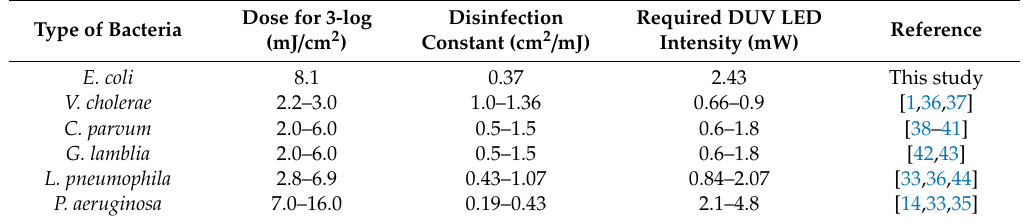
Table 1. Dose requirements vs. type of bacteria (first row) to obtain 3-log-level reductions (second row), disinfection constants (third row), and required DUV-LED intensity (fourth row) for E. coli , V. cholerae , C. parvum , G. lamblia , L. pneumophila , and P. aeruginosa . The values of the dose and the disinfection constants for species other than E. coli were evaluated using the references reported in the fifth